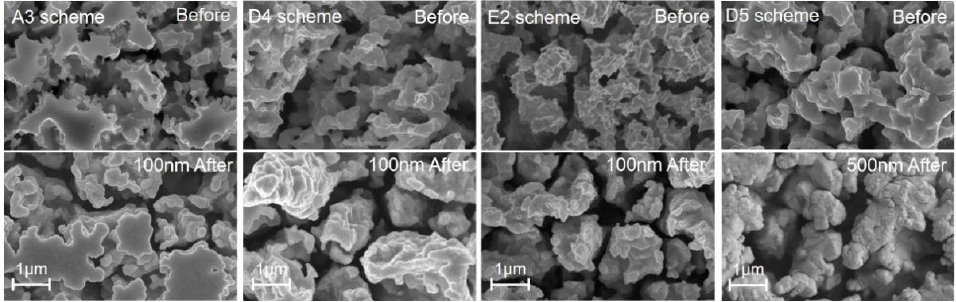
Figure 3. The SEM images of porous structures on samples using different schemes before and after the 100 nm/500 nm gold coating.